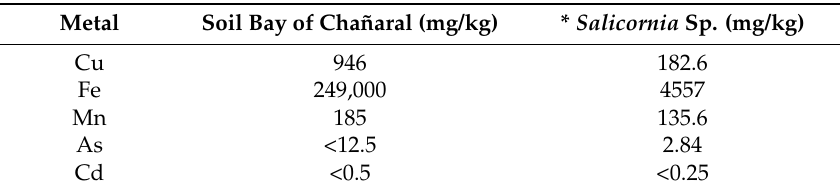
Table 5. Metal concentration in soil and plant in Chañaral Bay, north of Puchuncav í , at 800 km, on the same line of the